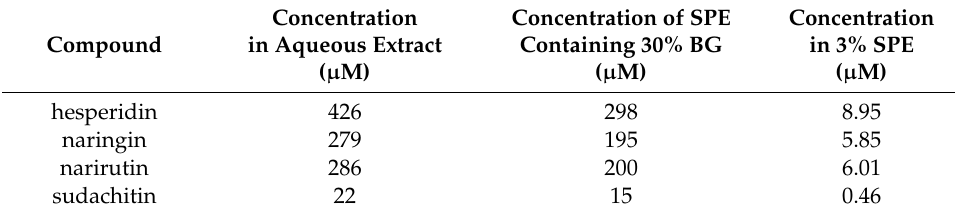
Table 1. Contents of polyphenolic compounds in the extract of C. sudachi